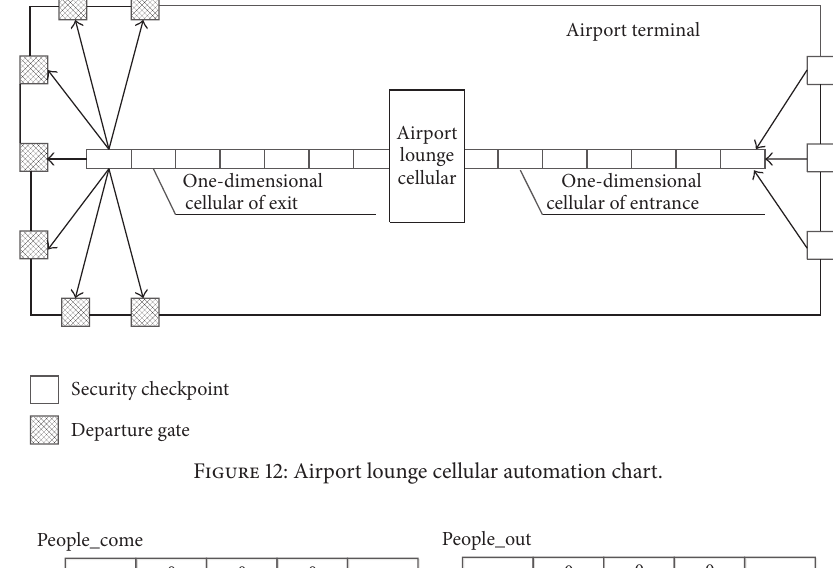
Figure 12: Airport lounge cellular automation chart.